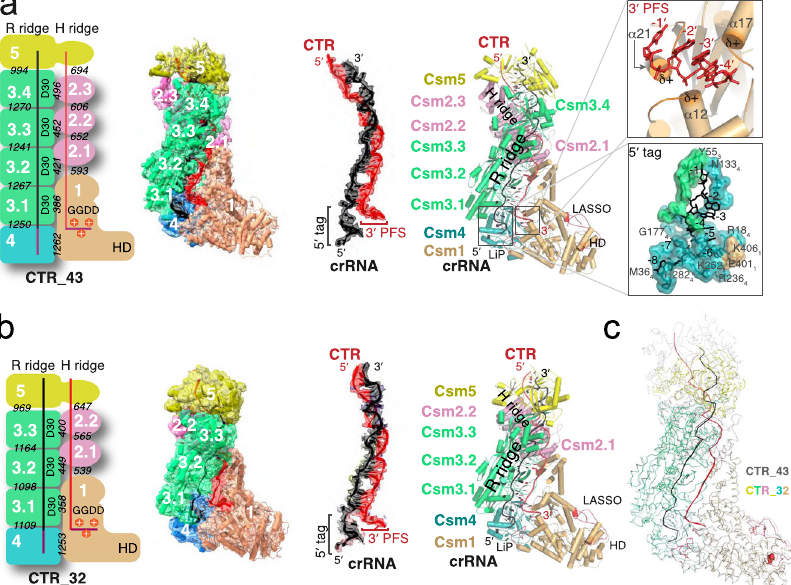
Fig. 2 Structures of Cognate target RNA (CTR)-bound LlCsm complex. Numbers in white indicate names of the subunit where N or N.m represent CsmN (or the mth CsmN). Key secondary elements are labeled. The crRNA and CTR are colored black and red, respectively. a Schematic representation, electron potential density, and cartoon representation of CTR-43 with stoichiometry 1 1 2 3 3 4 4 1 5 1 crRNA 1 Target 1 . Italicized numbers in black indicate the buried solvent-accessible surface of the corresponding subunits in Å 2 . The relative positions of crRNA 5 ′ -tag and the CTR 3 ′ -PFS are highlighted. The boxed image at the top displays three α -helices of LLCsm1: α 12, α 17, and α 21 that orient the positively charged N-terminus towards the 3 ′ -PFS of CTR, thus forming a favorable protein-RNA interaction. The boxed image towards the bottom displays the Csm3-Csm4 pocket where the 5 ′ -tag of crRNA traverses. b Schematic representation and overall structure of CTR-32 with stoichiometry 1 1 2 2 3 3 4 1 5 1 R 1 T 1 . The crRNA and CTR are colored black and red, respectively. The relative positions of crRNA 5 ′ -tag and the CTR 3 ′ -PFS are highlighted. c Ribbon representation of CTR-43 (gray) and CTR-32 (colored) with their Csm3 subunits superimposed highlighting structural differences in other